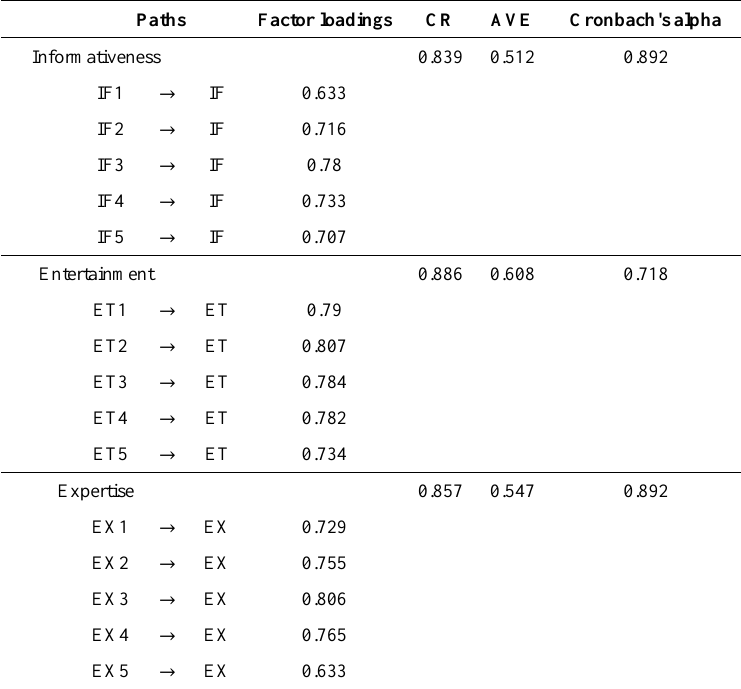
Table 3. CFA analysis and Model